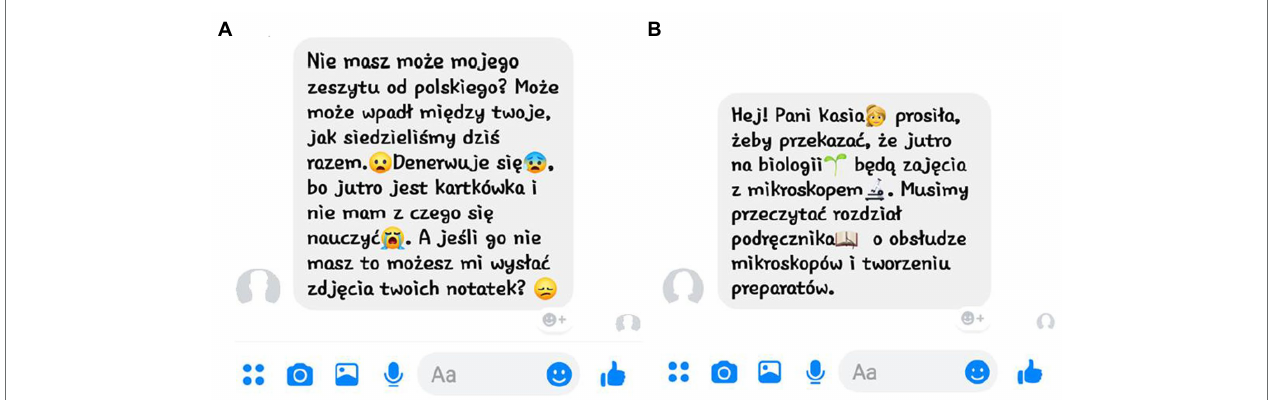
FIGURE 1 | Two sample messages with emoticons used in the experiment. (A) Emoticon-emotive (E-E) message, translated from Polish: Do you have my Polish class notebook? Maybe it ended up in your things, while we were sitting together . (emoticon) I am nervous (emoticon), because we have a test tomorrow and I cannot prepare without it (emoticon). If you do not have it, would you send me pictures of your notes? (emoticon). (B) Emoticon-informative (E-I) message, translated from Polish: Hey! Mrs. Jones (emoticon) asked to tell others that tomorrow in biology class (emoticon) we will work with microscopes (emoticon). We need to read a chapter from the manual (emoticon) on the use of the microscopes and the preparation of the samples . Message icons and layout ©